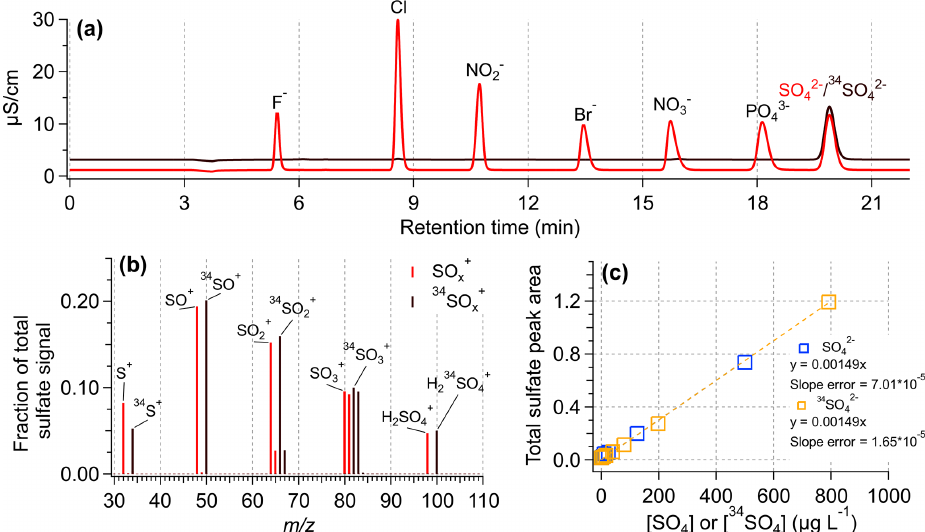
Figure 2. Assessment of the instrumental response to SO 4 and 34 SO 4 . (a) IC chromatograms of an anion standard mix (in light red) and a 34 SO 2 − standard. The SO 2 − and 34 SO 2 − concentrations were 3mgL − 1 in each solution. (b) HR-AMS mass spectra for a solution 4 4 4 containing equal concentrations of SO 4 and 34 SO 4 . The HR-AMS signal for the 34 SO 4 ions follow the expected trends based on the standard SO 4 ions. (c) IC standard calibration curves of sulfate (SO 2 − ) and isotopically labeled sulfate ( 34 SO 2 − 4 4